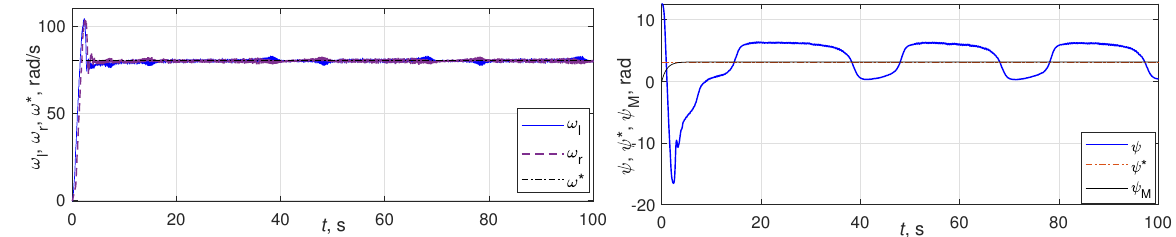
Figure 14. Experiment. Left plot : ω l ( t ) , ω r ( t ) , ω ∗ ( t ) ; right plot : ψ ( t ) , ψ ∗ ( t ) time histories for ω ∗ = 80 rad/s, ψ ∗ = π